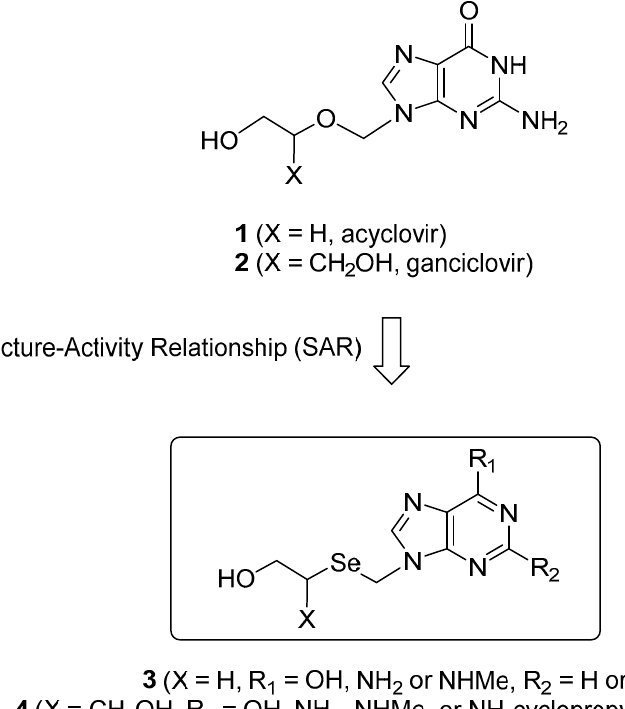
Figure 1. The rationale for the design of acyclic selenopurine nucleosides 3 and 4 based on the potent antiviral activity of 1 and 2 .